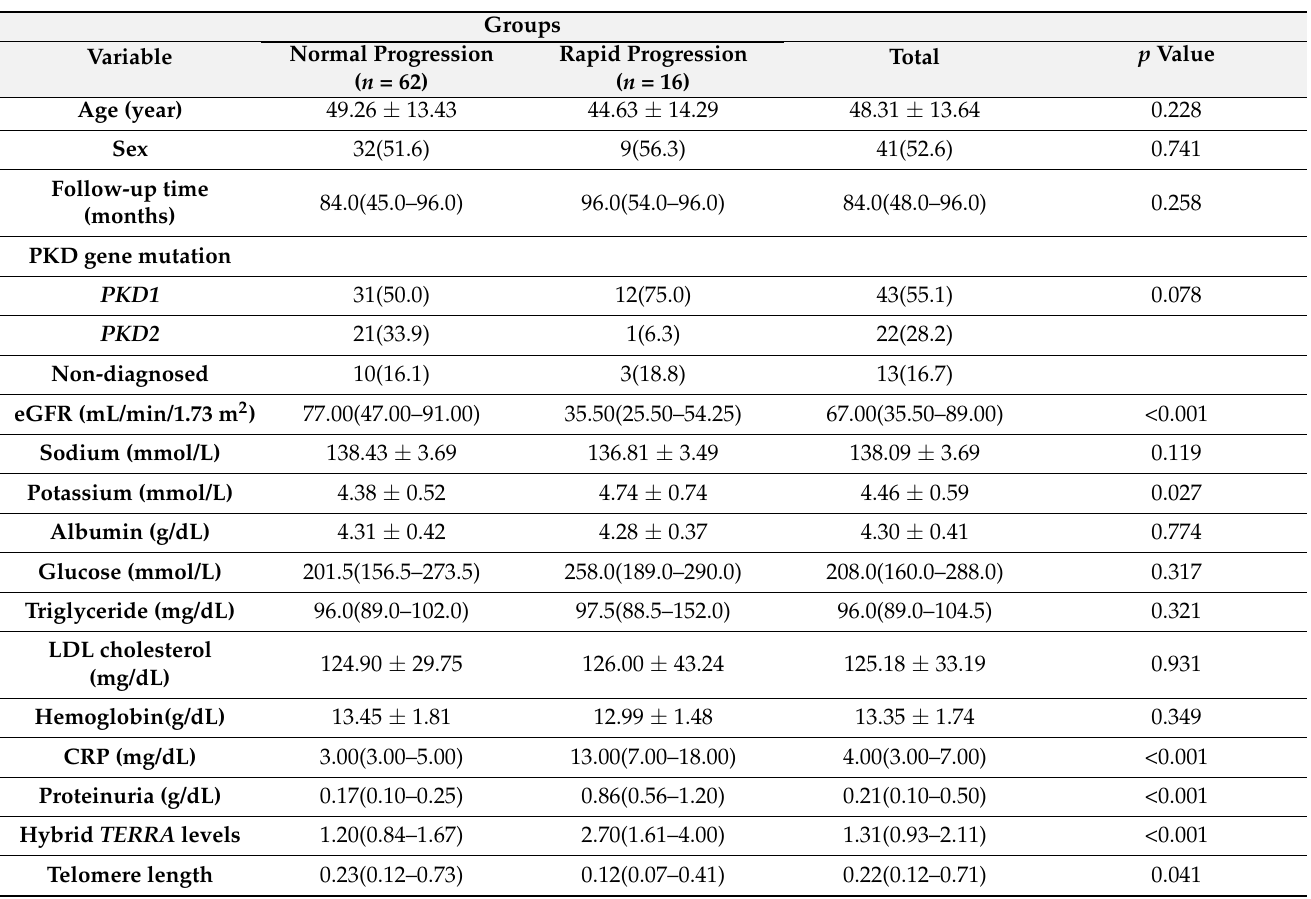
Table 3. Comparison of clinical variables between normal and rapidly progressive patients with ADPKD; data were summarized as n (%), mean ± standard deviation or median (1st–3rd quartiles). Significant p values are shown in